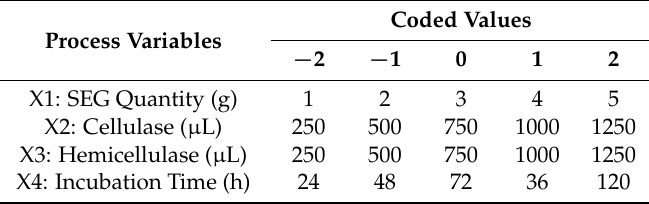
Table 1. Process variables and their coded levels in the Box-Wilson Central Composite